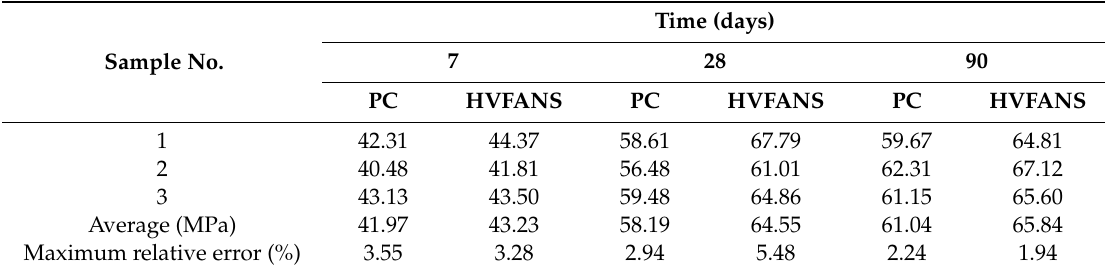
Table 3. Curing age e ff ect on the response of PC and HVFANS concrete at 400 ◦ C.